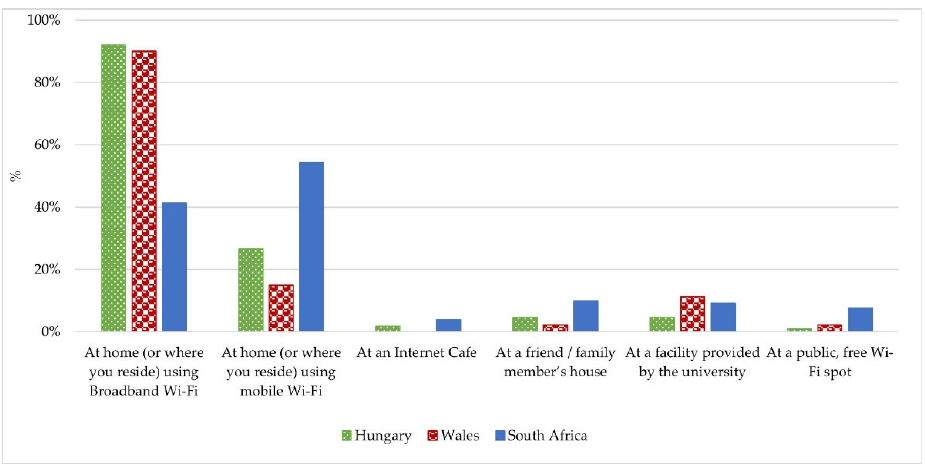
Figure 13. Student access to the online university environment.